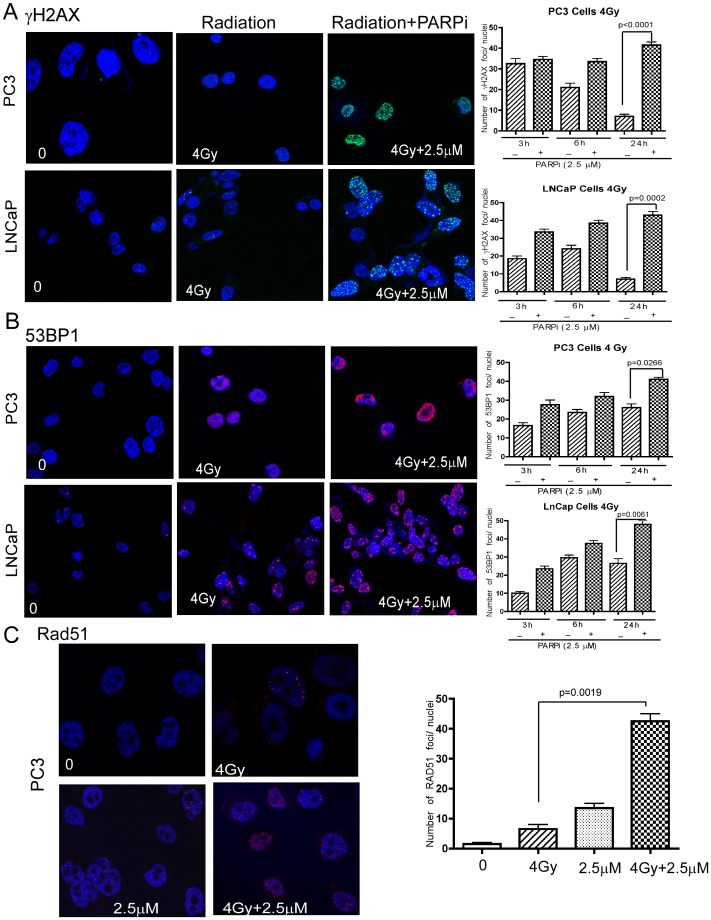
Combination of rucaparib with radiation increases χH2AX and 53BP1 foci leading to persistent DNA damage.
χH2AX (A) and 53BP1 (B) foci were determined by immunofluoresecence microscopy at 24 h following combined treatment with radiation and rucaparib in PC3 and LNCaP cells (left panel), with time-dependent kinetics shown (right panel). C, Rad51 foci were visualized and quantified in PC3 cells similarly after 24 h of treatment. Error bars represent SD of mean (n = 3).